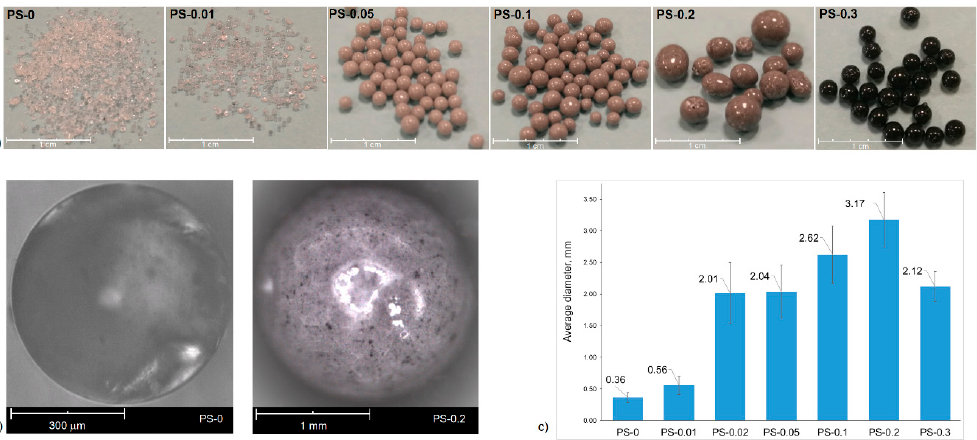
Figure 2. Characterisation of pure PS and PS / rGO beads: ( a ) digital photos; ( b ) optical microscope images of PS-0 and PS-0.2 beads; ( c ) average diameters of beads size.